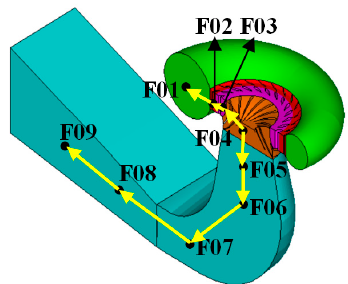
Figure 15. Presentation of pressure pulsation transmission path based on the 18.75 Hz wavelet transformation.